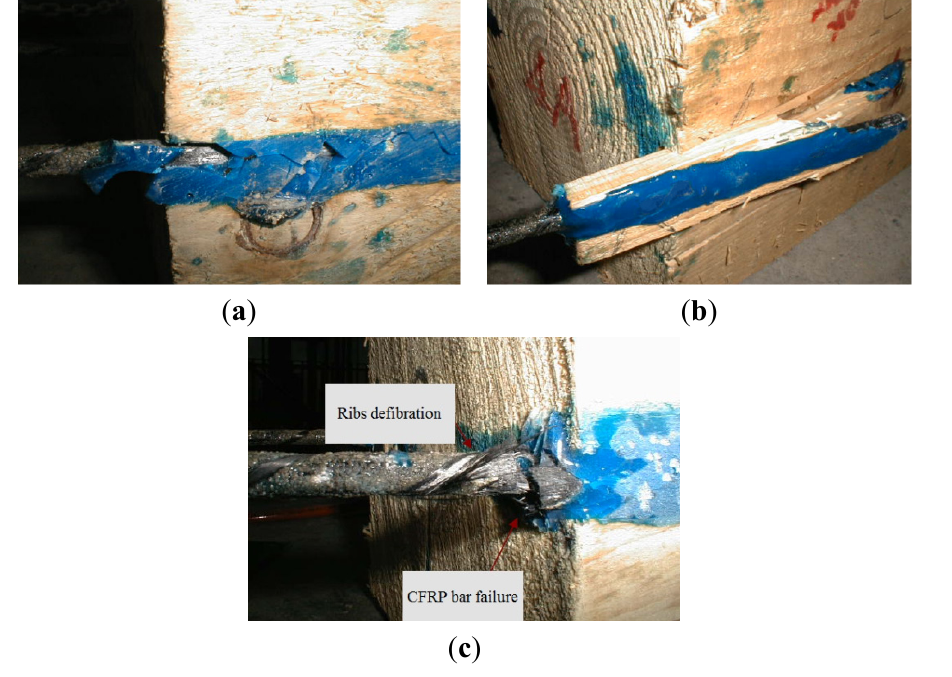
Figure 8. Failure modes: ( a ) bar pull-out; ( b ) timber shear failure; ( c ) CFRP bar tensile failure. The second failure mode was frequent for soft wood (fir) specimens with small bonded lengths